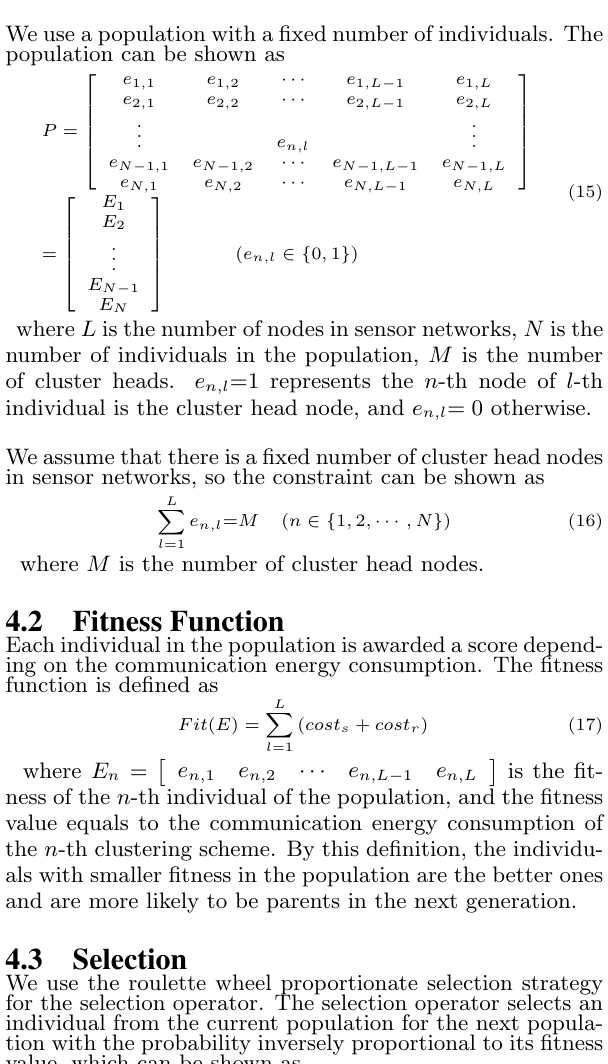
Fig.3 and Fig.4 show the communication energy consump- tion of the high-density WSN using FSEC, the PSO and QEA with 300 and 400 nodes respectively, where the energy consumption is obtained directly from the formula (1) and (2). The cluster head proportion is 10%. The results are the average over 10 runs with different random nodes distribu- tions. According to these comparisons, the proposed